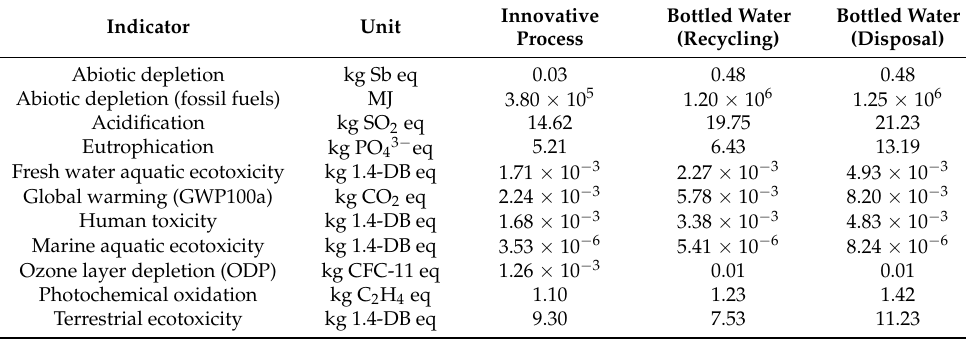
Table 3. Potential environmental impacts of different water treatments.